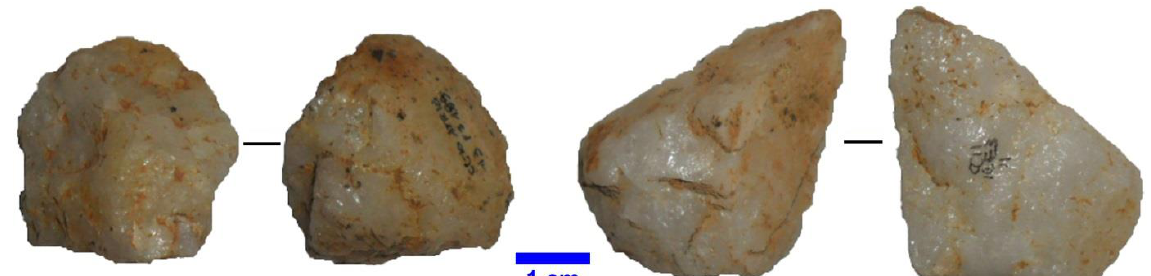
Figure 8.Discoid core (on the left) and side-scraper on pseudo- Levallois point (on the right) from the Ciota Ciara cave. The scale bar in the image is 1 cm wide.